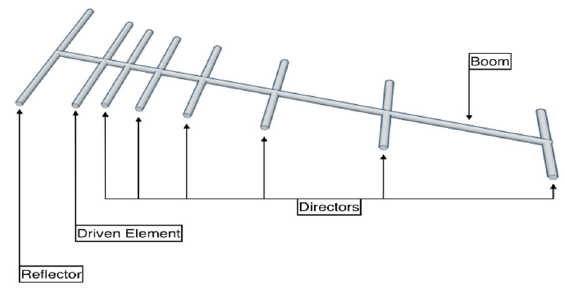
Figure 5. Yagi-Uda antenna